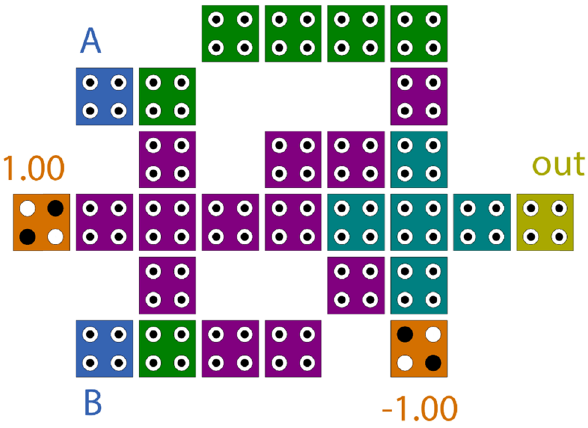
Figure 7: 2 - input XOR gate proposed in ref. [ 30 ] .